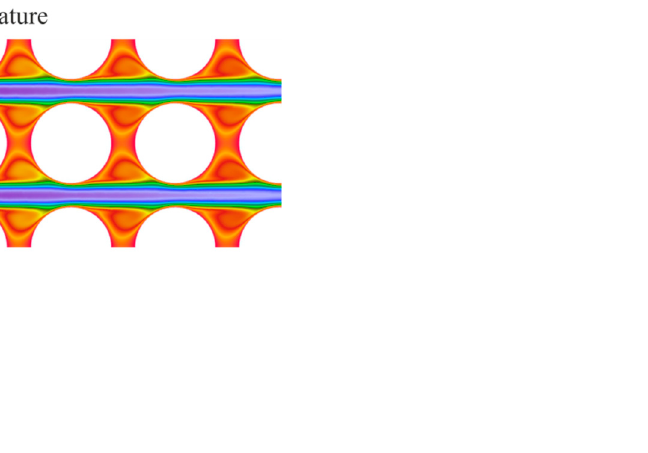
Figure 15. The temperature contour plots for the three central rows of the tube bundle at a steady flow.